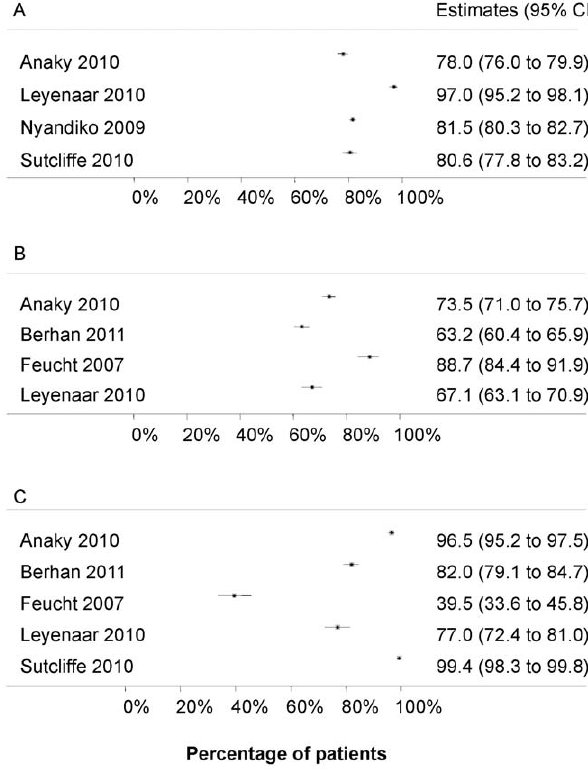
Figure 2. Forest plots – time from HIV diagnosis to start of antiretroviral therapy (ART). A): Percentage of HIV positive children with a CD4 cell count/percentage. B): Percentage of children with an eligibility assessement who meet eligibility criteria for ART. C): Percentage of ART eligible children starting ART.